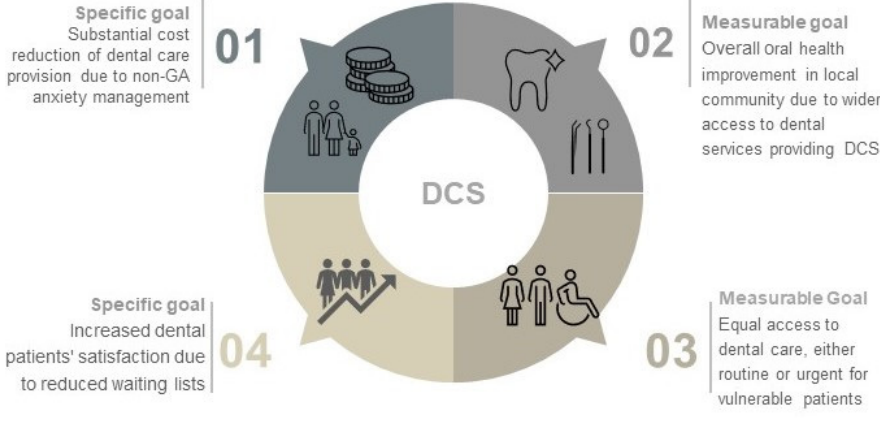
Figure 1. The benefits of dental conscious sedation in primary healthcare setting.